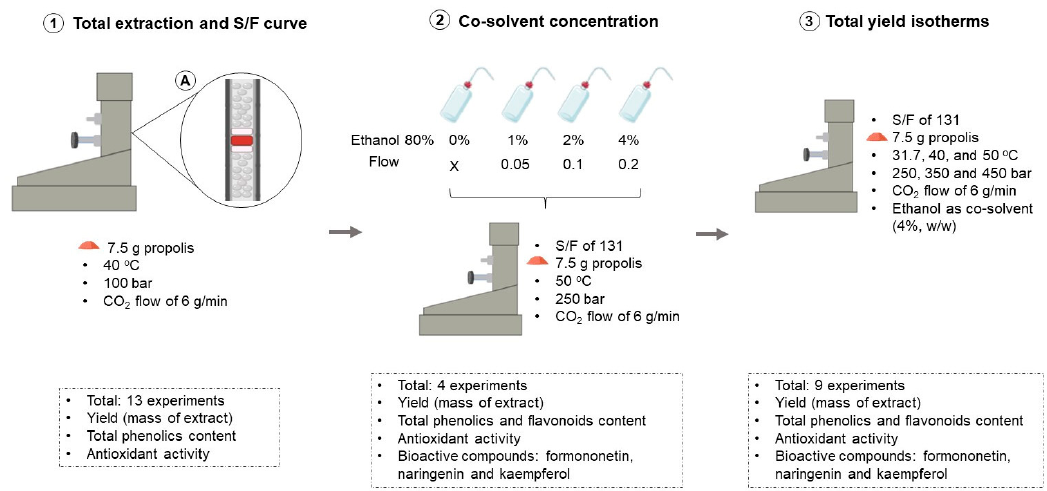
Figure 8. Illustrative summary of the steps, parameters used, total experiments and analyses performed at each step of the present study to obtain red propolis extract with high antioxidant capacity by SFE. 1 —First step: determination of the overall extraction curve and S/F (mass of CO 2 /mass of sample); 2 —Second step: influence of the cosolvent percentage; 3 —Third step: determination of the global yield isotherms. In A, the packing of the extraction bed to avoid the formation of preferential CO 2 paths is shown.